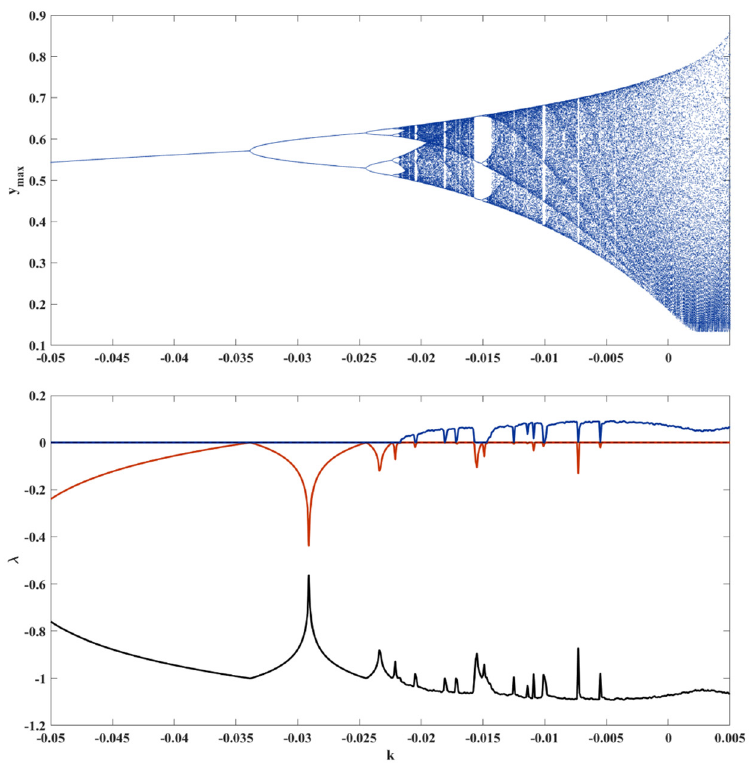
Figure 3. The bifurcation diagrams of System (1) versus k parameter and corresponding Lyapunov exponents for initial conditions (0, − 1, 0).